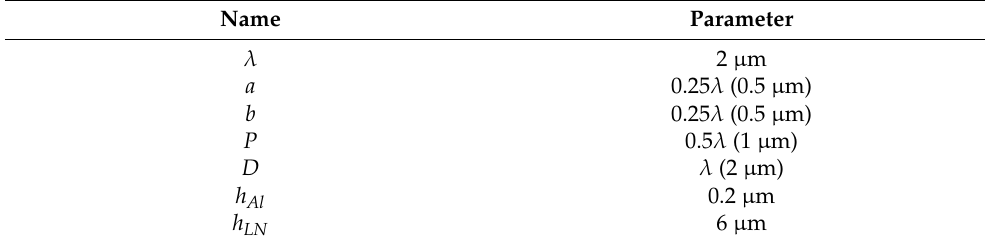
Figure 2. Simulation modeling process for SAWS. ( a ) Selection of periodic element for the two- dimensional model of SAWS; ( b ) two-dimensional finite element model construction and related parameters; ( c ) two-dimensional model of SAWS in finite element simulation; ( d ) potential distribu- tion of SAW in simulation modeling. Table 1. Initial structural parameters of the simulation model.